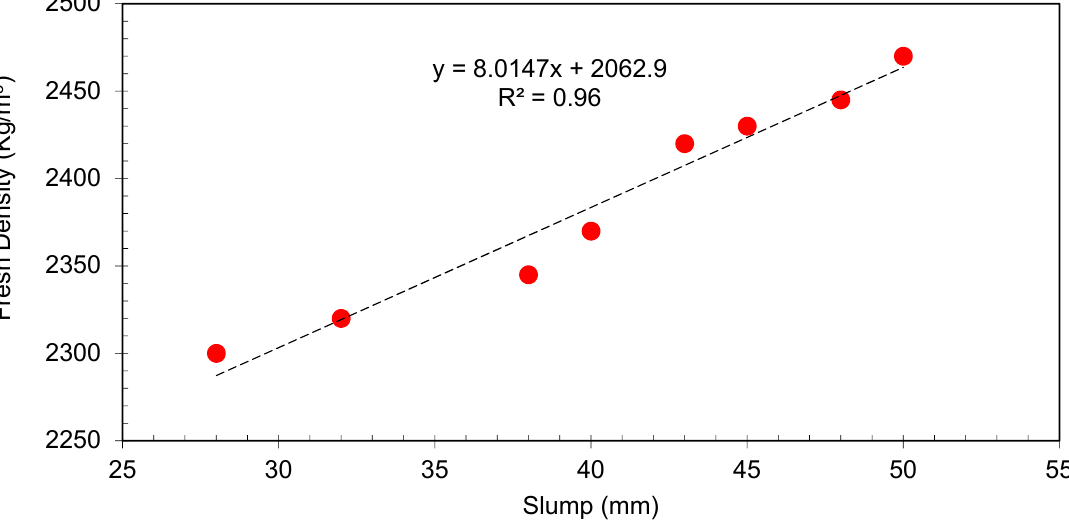
Figure 4. Correlation between slump and fresh density (data source [44]).